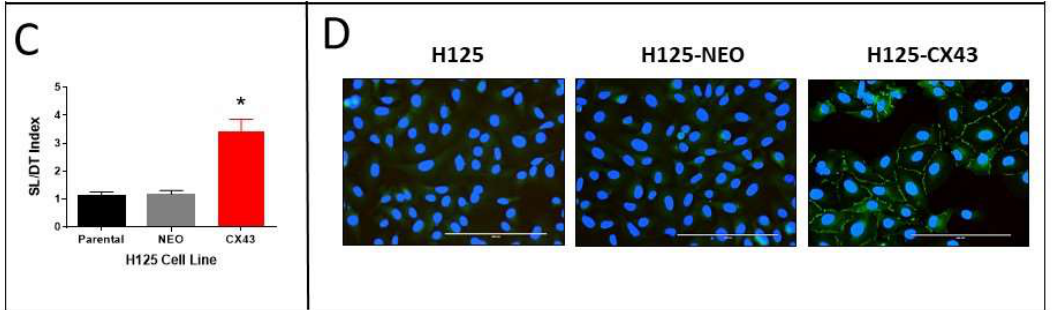
Figure 1. Stable transfection of connexin43 (Cx43) in H125 cells (H125-CX43) increases gap junction formation, gap junctional intercellular communication (GJIC), and E-cadherin and β-catenin localization to the plasma membrane (non-transfected parental cells are designated H125 and empty vector-transfected cells are designated H125-NEO). ( A ) Western blot of Cx43 and densitometric analysis of band densities normalized to tubulin loading control ( n = 3 replicate experiments); ( B ) scrape-loading/dye-transfer assay for GJIC showing Lucifer Yellow-fluorescent dye-loaded cells (top panels) and bright field images (bottom panels), scale bars: 400 µm; ( C ) quantification of average number of dye-loaded cells perpendicular to the scrape (* p < 0.01, Student’s t -test, mean ± S.D., n = 4 replicate experiments); ( D ) fluorescent fluorescein isothiocyanate (FITC) immunostaining of Cx43 with 4 (cid:48) ,6-diamidino-2-phenylindole (DAPI) staining of nuclei, scale bars: 200 µ m.